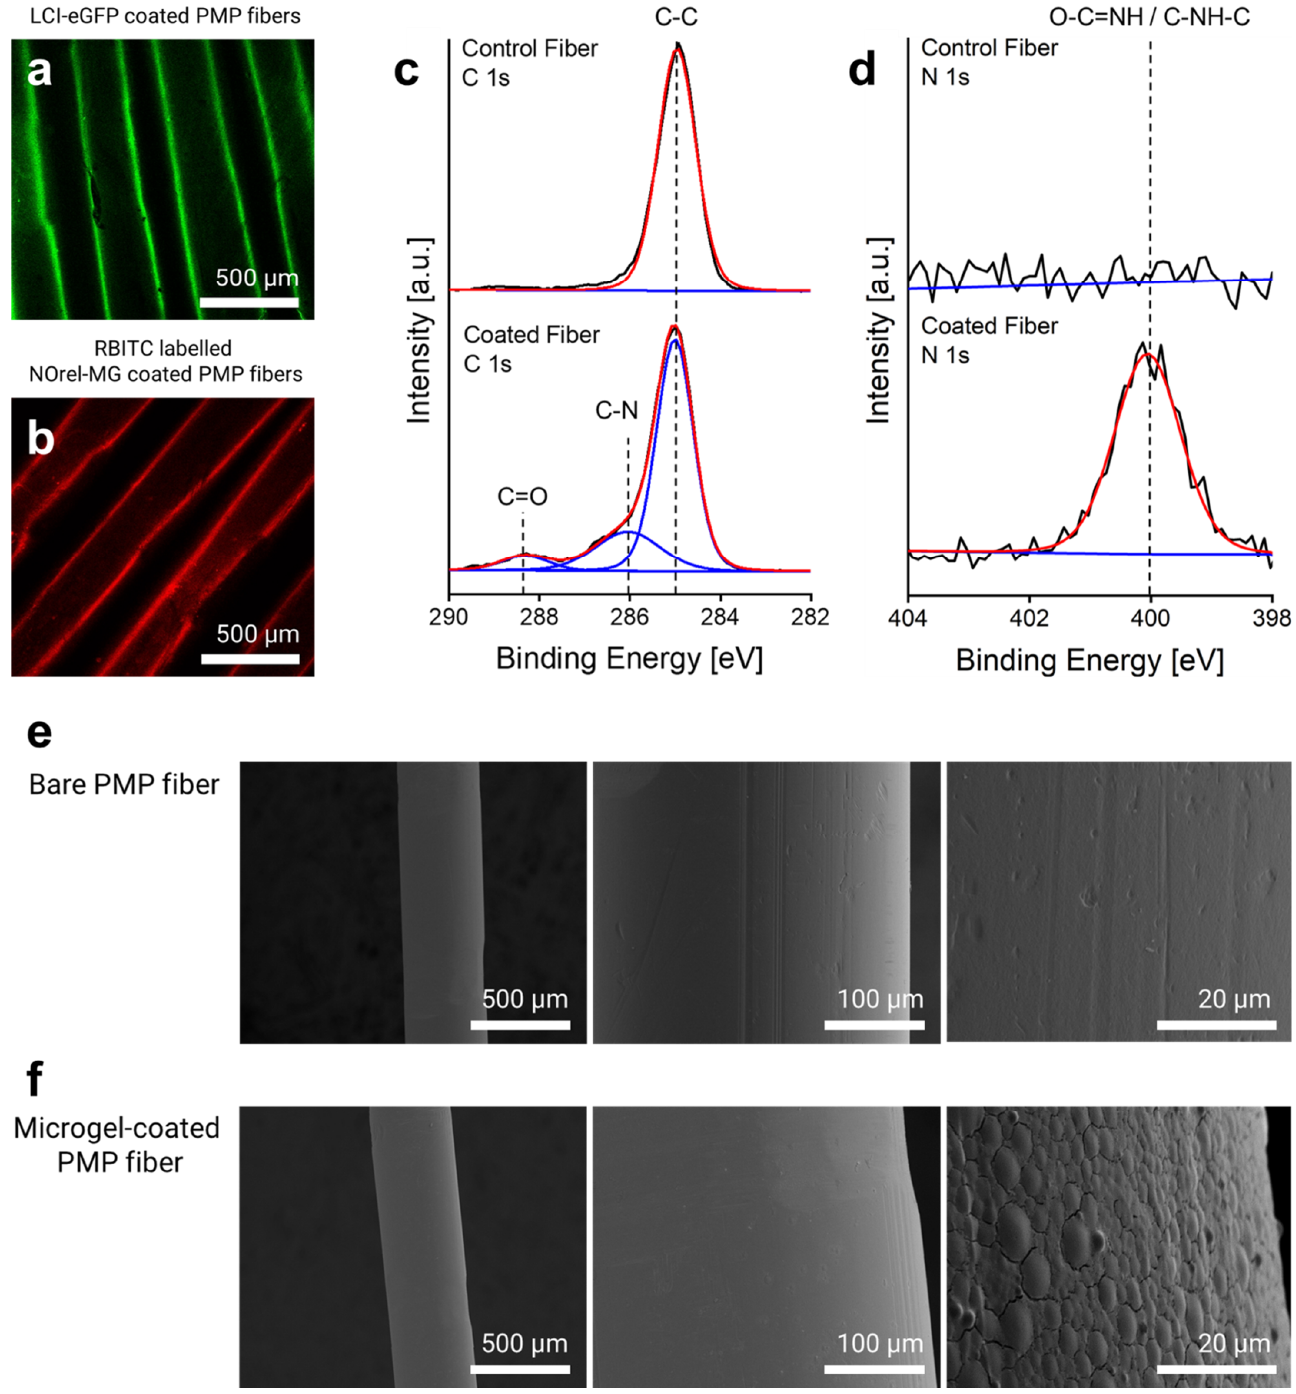
Figure 1. Microgel-coating characterization: CLSM imaging of ( a ) eGFP-LCI-treated and ( b ) Microgel-coated PMP fibers. High-resolution ( c ) C1s and ( d ) N1s X-ray Photoelectron Spectroscopy (XPS) spectra of the control (uncoated) and microgel-coated fibers reveal the corresponding signals. SEM micrographs of the surface morphology of the PMP fiber ( e ) before and ( f ) after microgel